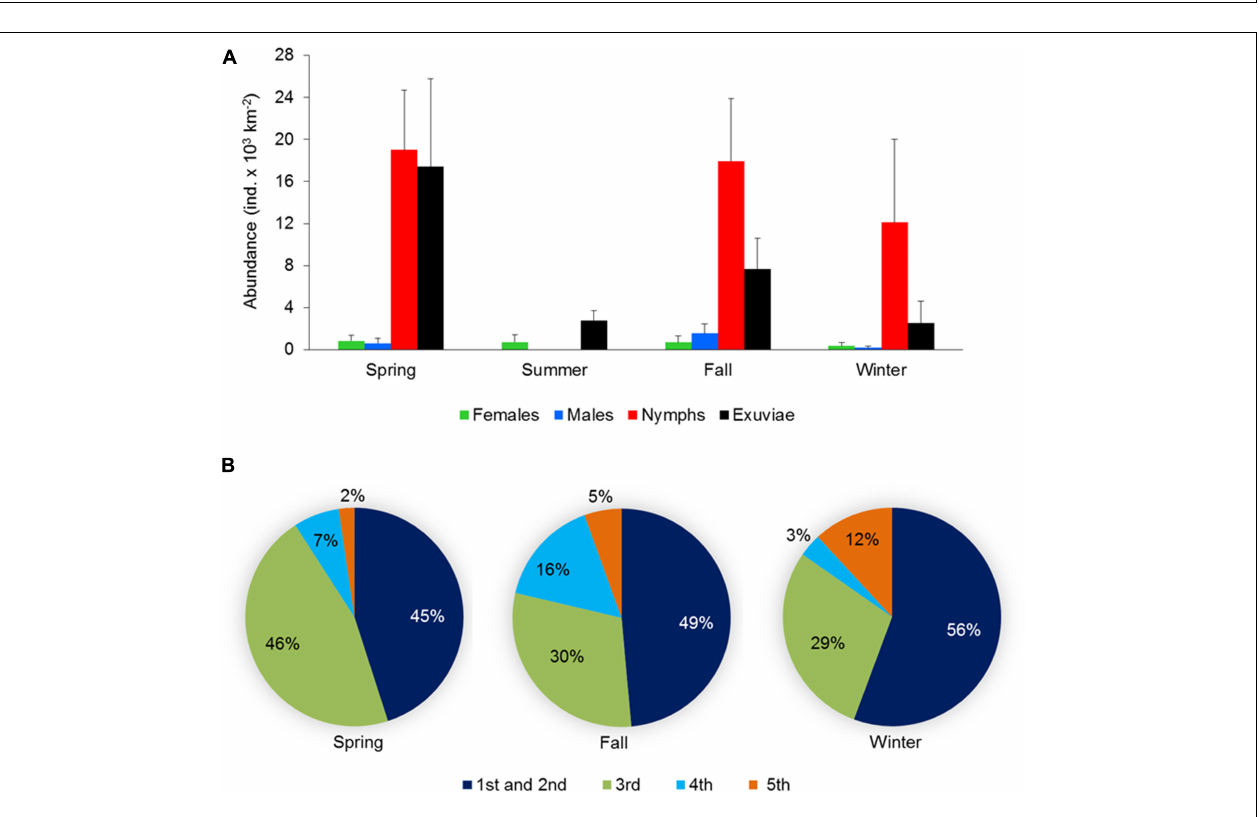
FIGURE 4 | (A) Abundance and population structure (females, males, and nymphs) and exuviae of Halobates germanus during different seasons and (B) relative contribution of different instar stages to the total nymph population observed at the fixed station in central Red Sea during 2016–2018. Error bars indicate standard error of the